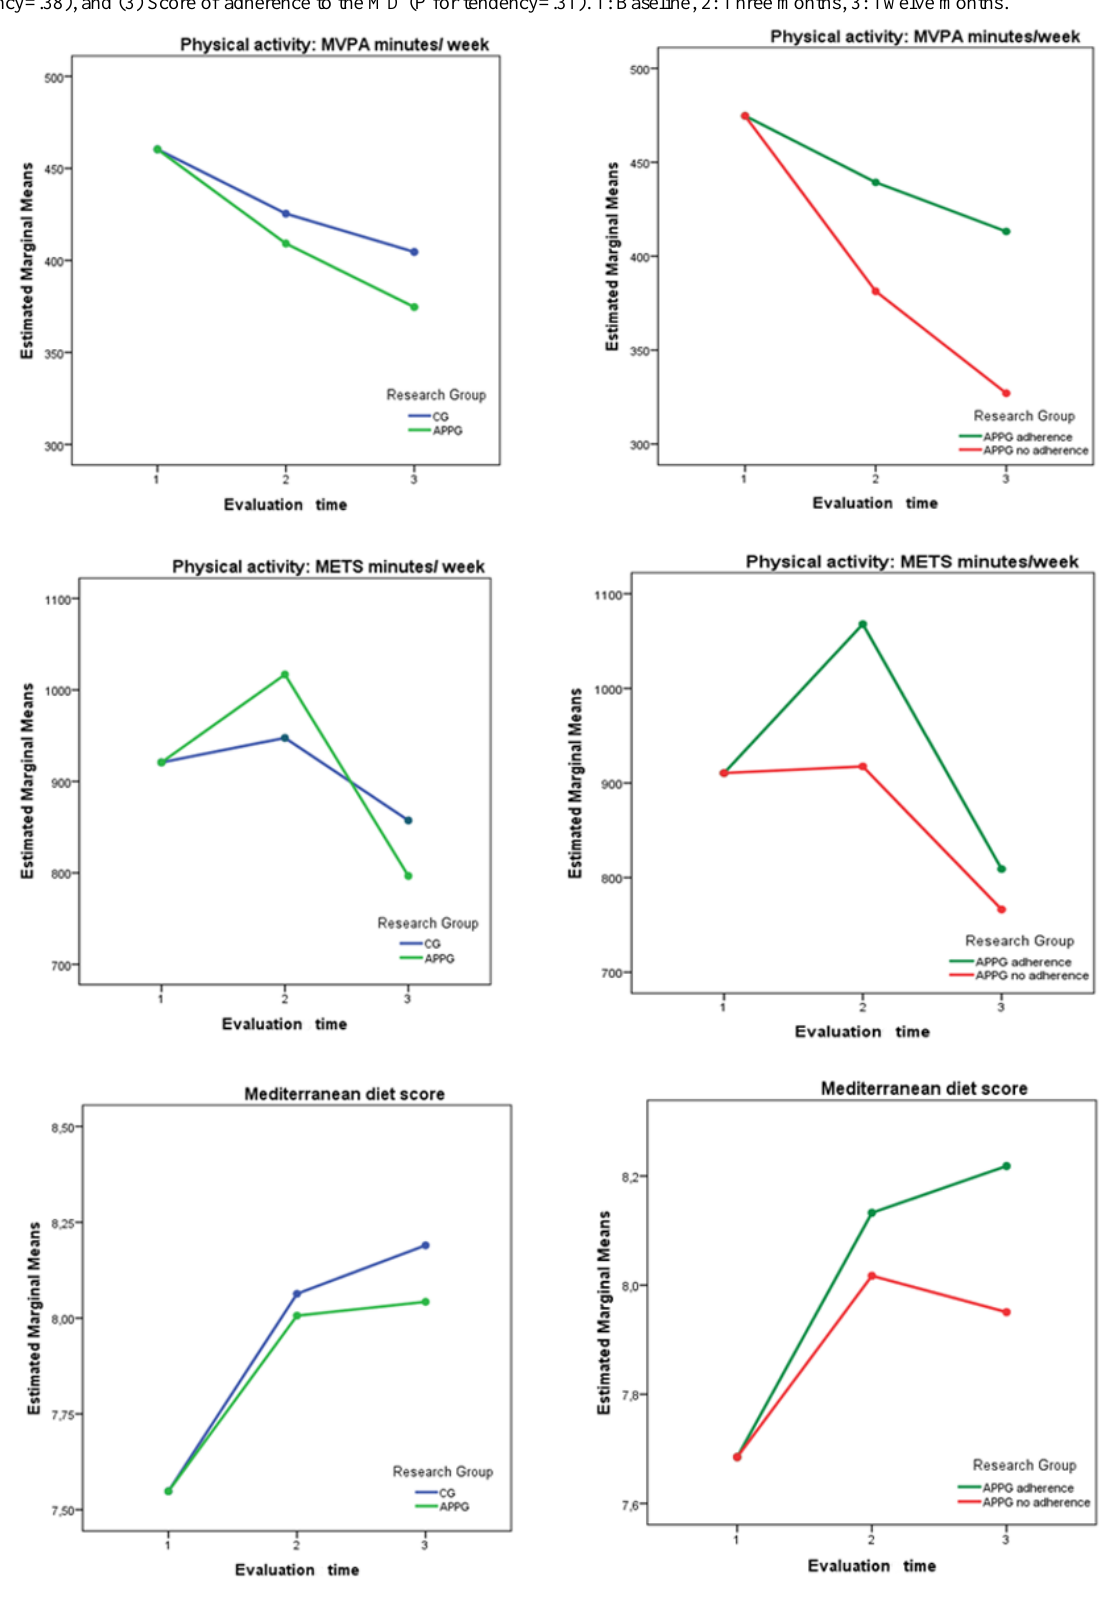
Figure 2. Evolution of physical activity and adherence to the Mediterranean diet at 3 and 12 months. (A) Comparison of the evolution of counseling + app group (APPG) versus the control group (CG) showing (1) moderate to vigorous physical activity (MVPA) minutes per week by accelerometer (P value for tendency=.15), (2) Metabolic equivalents (METs) minutes per week by 7-day Physical Activity Recall or PAR (P value for tendency=.245), and (3) Score of adherence to the Mediterranean diet (MD) (P value for tendency=.465). (B) Comparison of the evolution of APPG with high adherence versus IG with low adherence showing (1) MVPA min per week by accelerometer (P for tendency=.001), (2) METS min per week by 7-day PAR (P for tendency=.38), and (3) Score of adherence to the MD (P for tendency=.31). 1: Baseline, 2: Three months, 3: Twelve